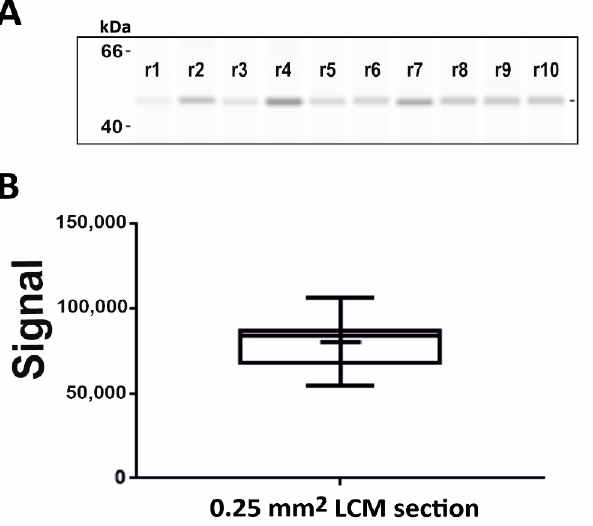
Figure 3. Reproducibility of LCM-cap-IA integration: Signal response of β -actin on 0.25 mm 2 dis- sected LCM samples from rat kidney tissues with 10 µ m thickness: ( A ) Gel-like image representation of cap-IA signals, ( B ) Data analysis of the area under the curve from 10 technical replicates, processed separately. Data were analyzed by box and whisker graph.